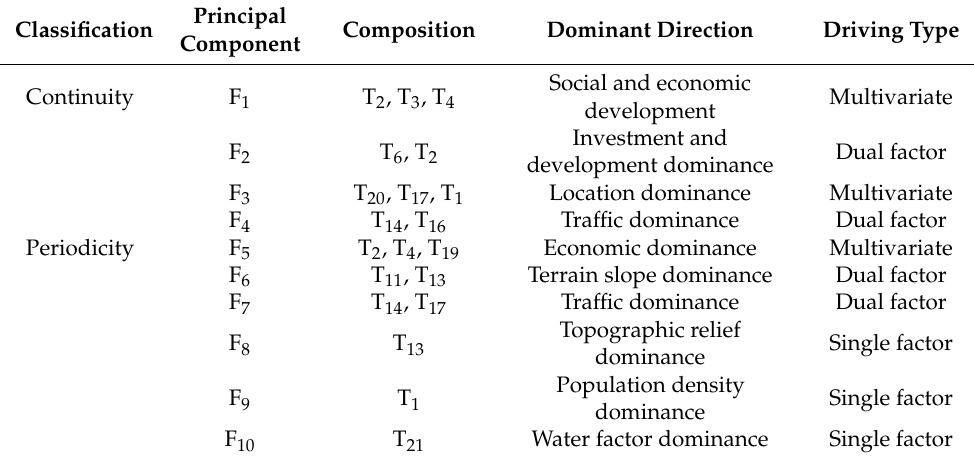
Table 5. Dominant factors of principal component driving